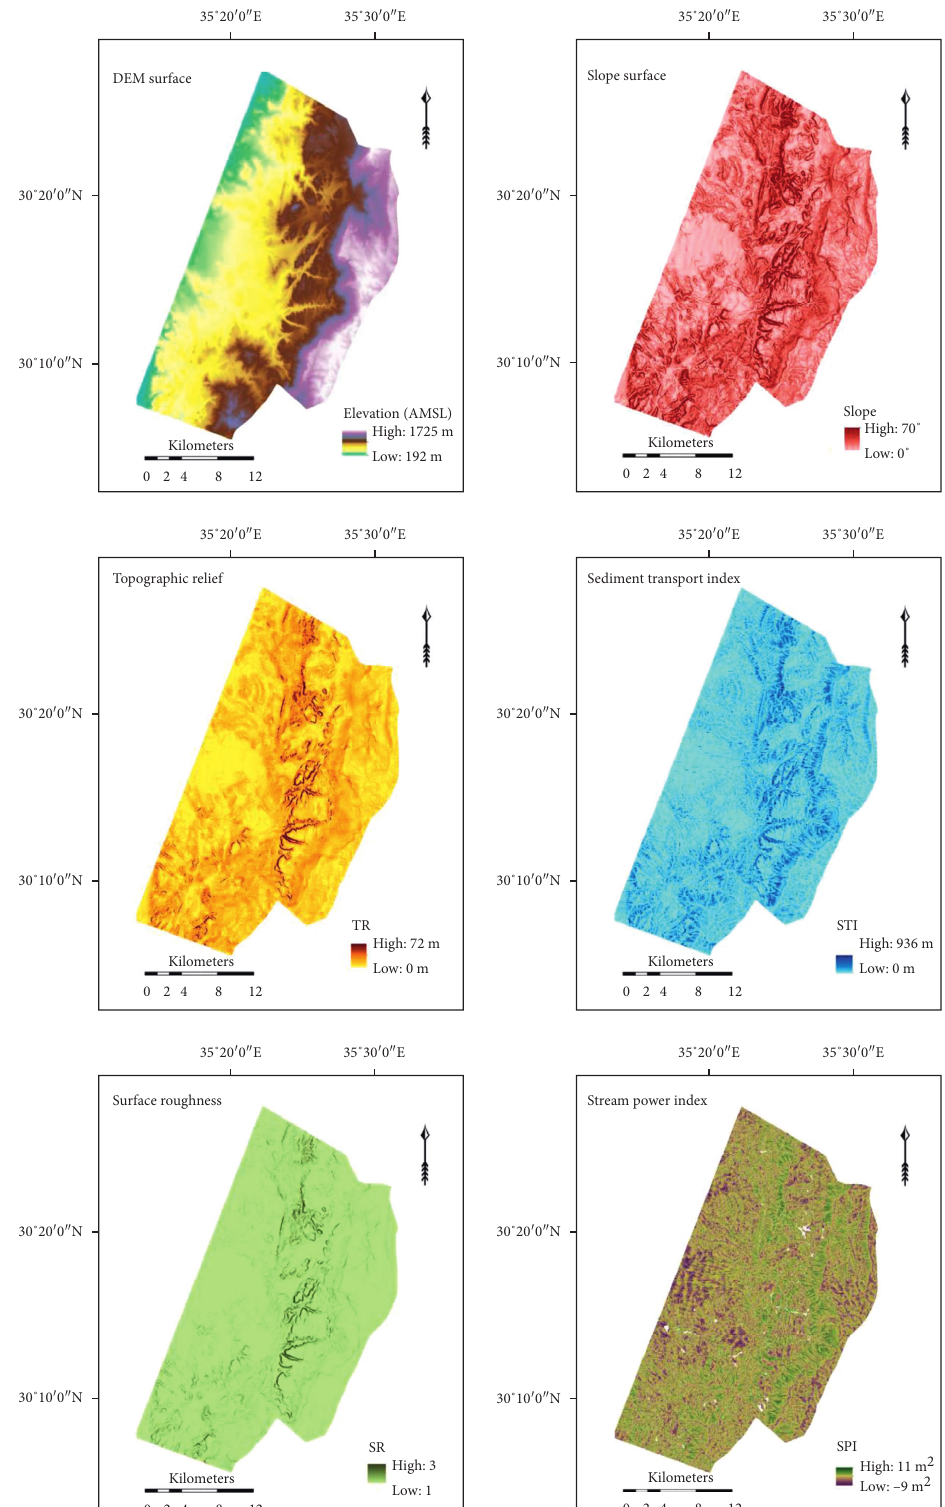
Figure 13: DEM dataset and topographic metrics applied for characterizing terrain